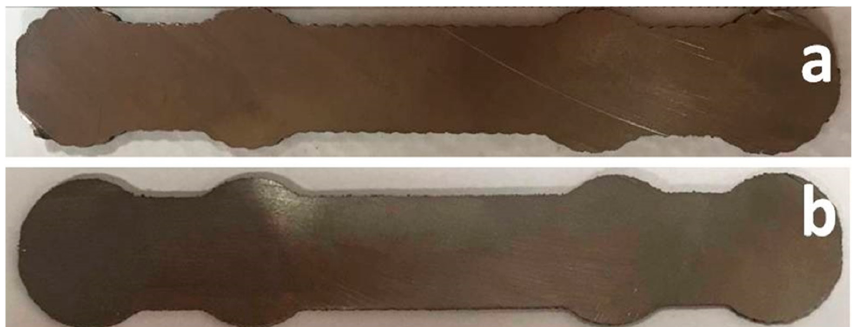
Figure 13. ( a ) Intermediate form with waved edges, obtained by Laser Melting Deposition (LMD) printing following a longitudinal meander trajectory and ( b ) intermediate form with improved edges by supplemental tracing of contour.